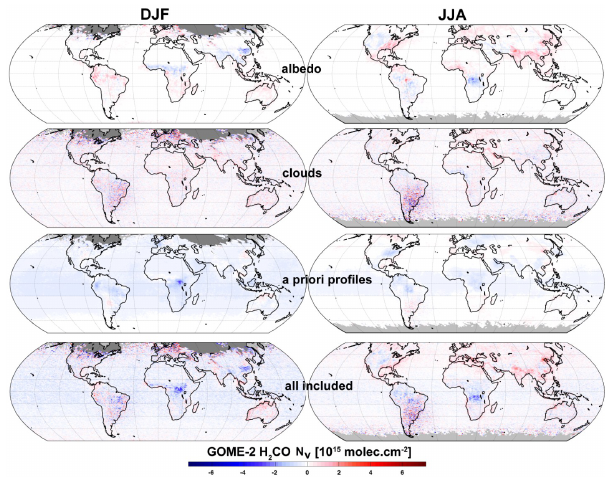
Fig. 8. Absolute differences in H 2 CO vertical columns (VC) from Figure 8: Absolute differences in H 2 CO vertical columns (VC) from air mass factor parameter air mass factor parameter updates (new version-previous version). updates (new version-previous version). The left and right columns show the seasonally averaged VC differences, respectively in DJF and in JJA 2007. First row: update of the surface albedo The left and right columns show the seasonally averaged VC dif- climatology (previous version: Koelemeijer et al. (2003), new version: Kleipool et al. (2008)). ferences, respectively in DJF and in JJA 2007. First row: update Second row: update of the cloud product (previous version: Fresco v5, new version: Fresco v6). of the surface albedo climatology (previous version: Koelemeijer et Third row: update of the a priori profiles from IMAGESv2 (previous version: monthly profiles, al., 2003, new version: Kleipool et al., 2008). Second row: update of 5°x5°, new version: daily profiles, 2°x2.5°). The two lower panels show the combined effects of the the cloud product (previous version: Fresco v5, new version: Fresco three AMF parameter updates. v6). Third row: update of the a priori profiles from IMAGESv2 (pre- vious version: monthly profiles, 5 × 5 ◦ , new version: daily profiles, 2 × 2 . 5 ◦ ). The two lower panels show the combined effects of the three AMF parameter